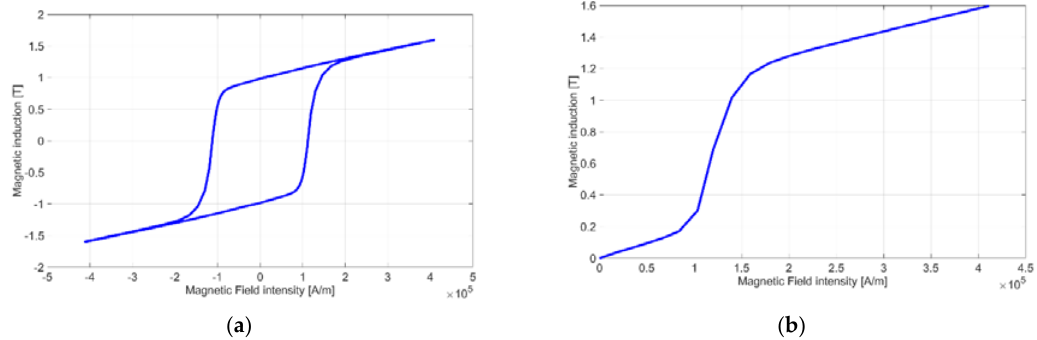
Figure 8. Major loop of the hysteresis